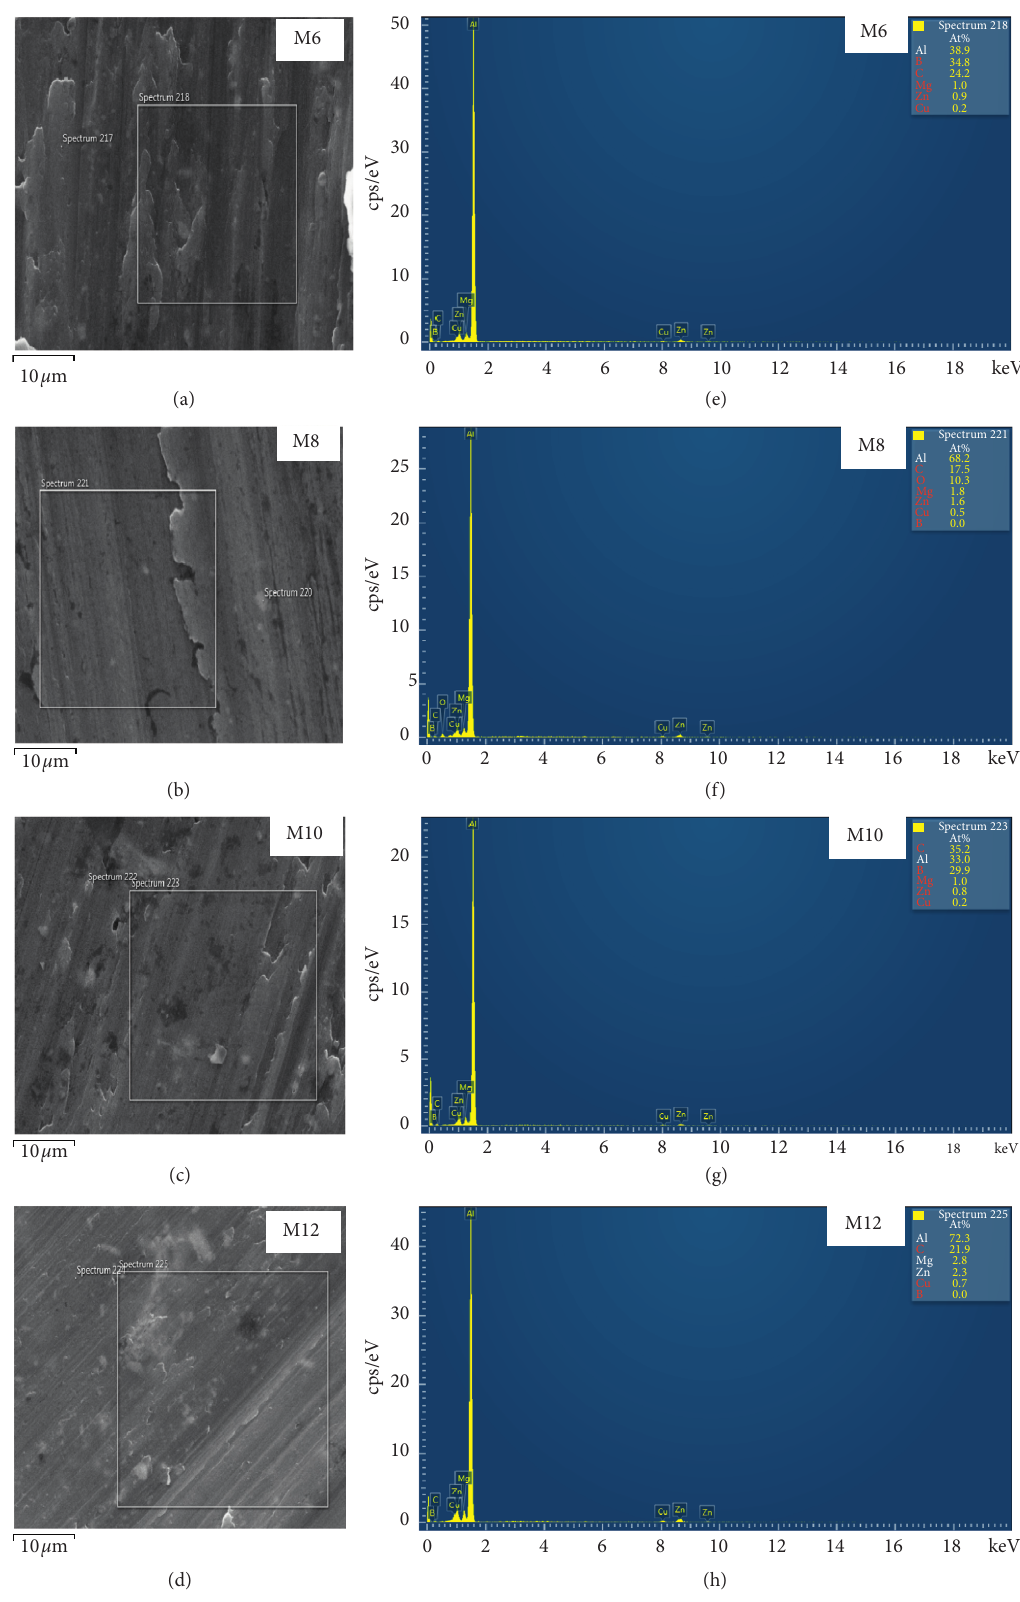
Figure 5: SEM micrographs and EDS spectrums of different compositions of the Al7075-B (e) M6. (f) M8. (g) M10. (h)